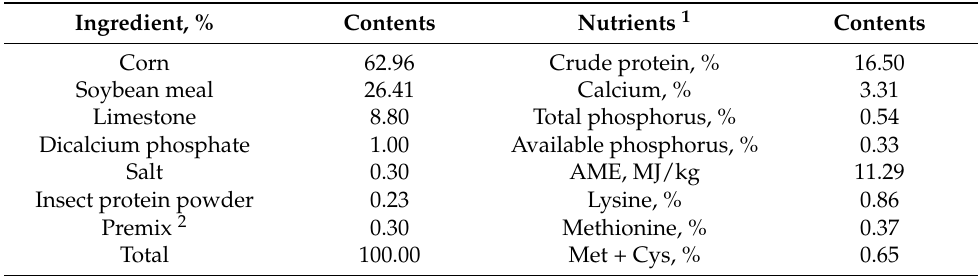
Table 1. The composition and nutrient levels of the basal diet. Ingredient, % Nutrients 1 Corn